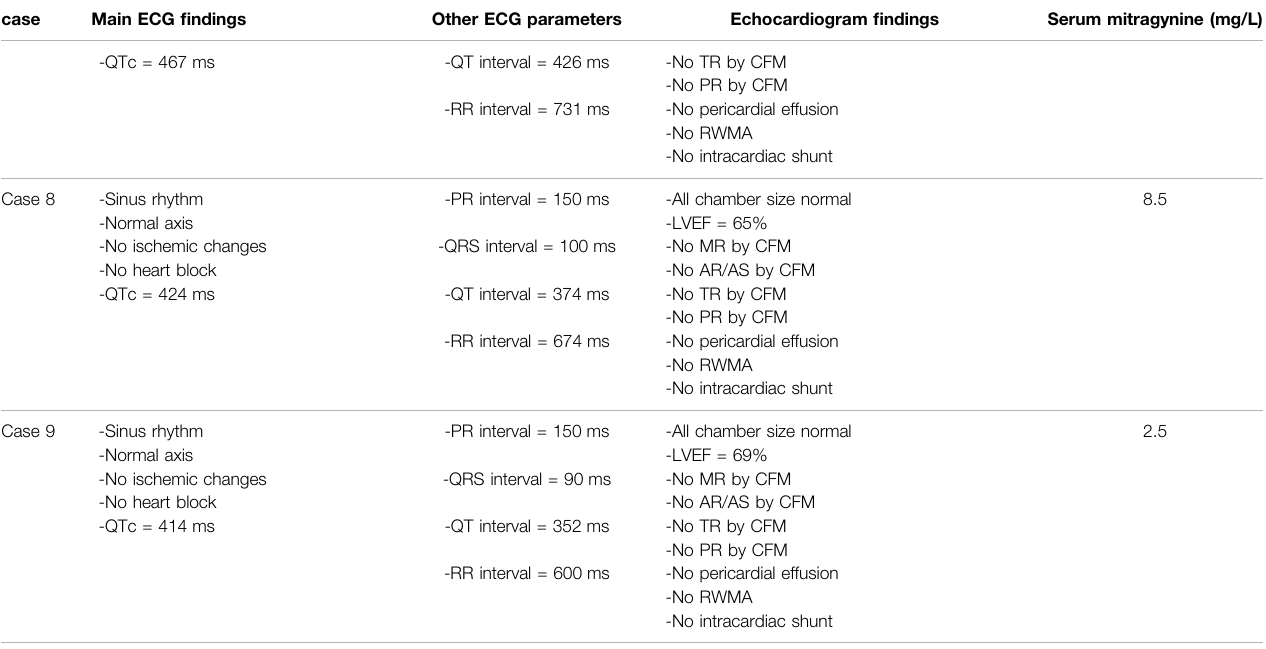
TABLE 2 | ( Continued ) Cardiovascular fi ndings and serum mitragynine level of the respondents.